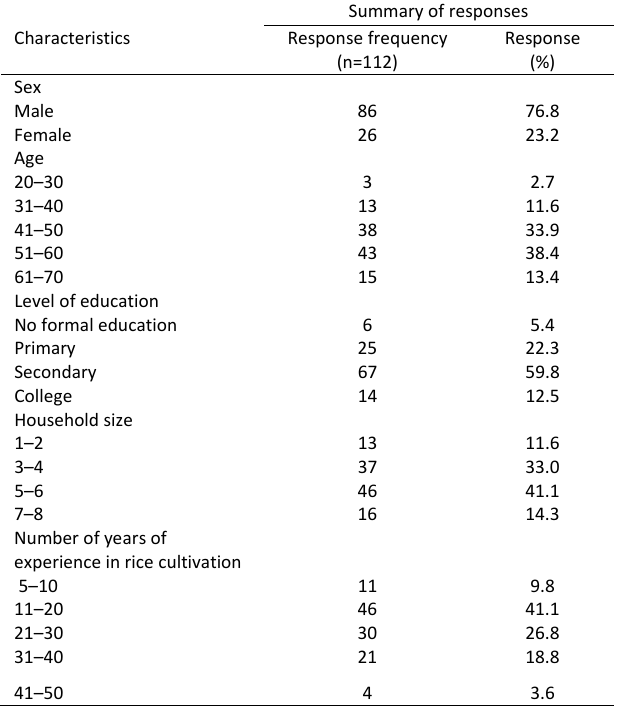
Table 1: Sociodemographic characteristics of farmers in the three barangays in North Cotabato